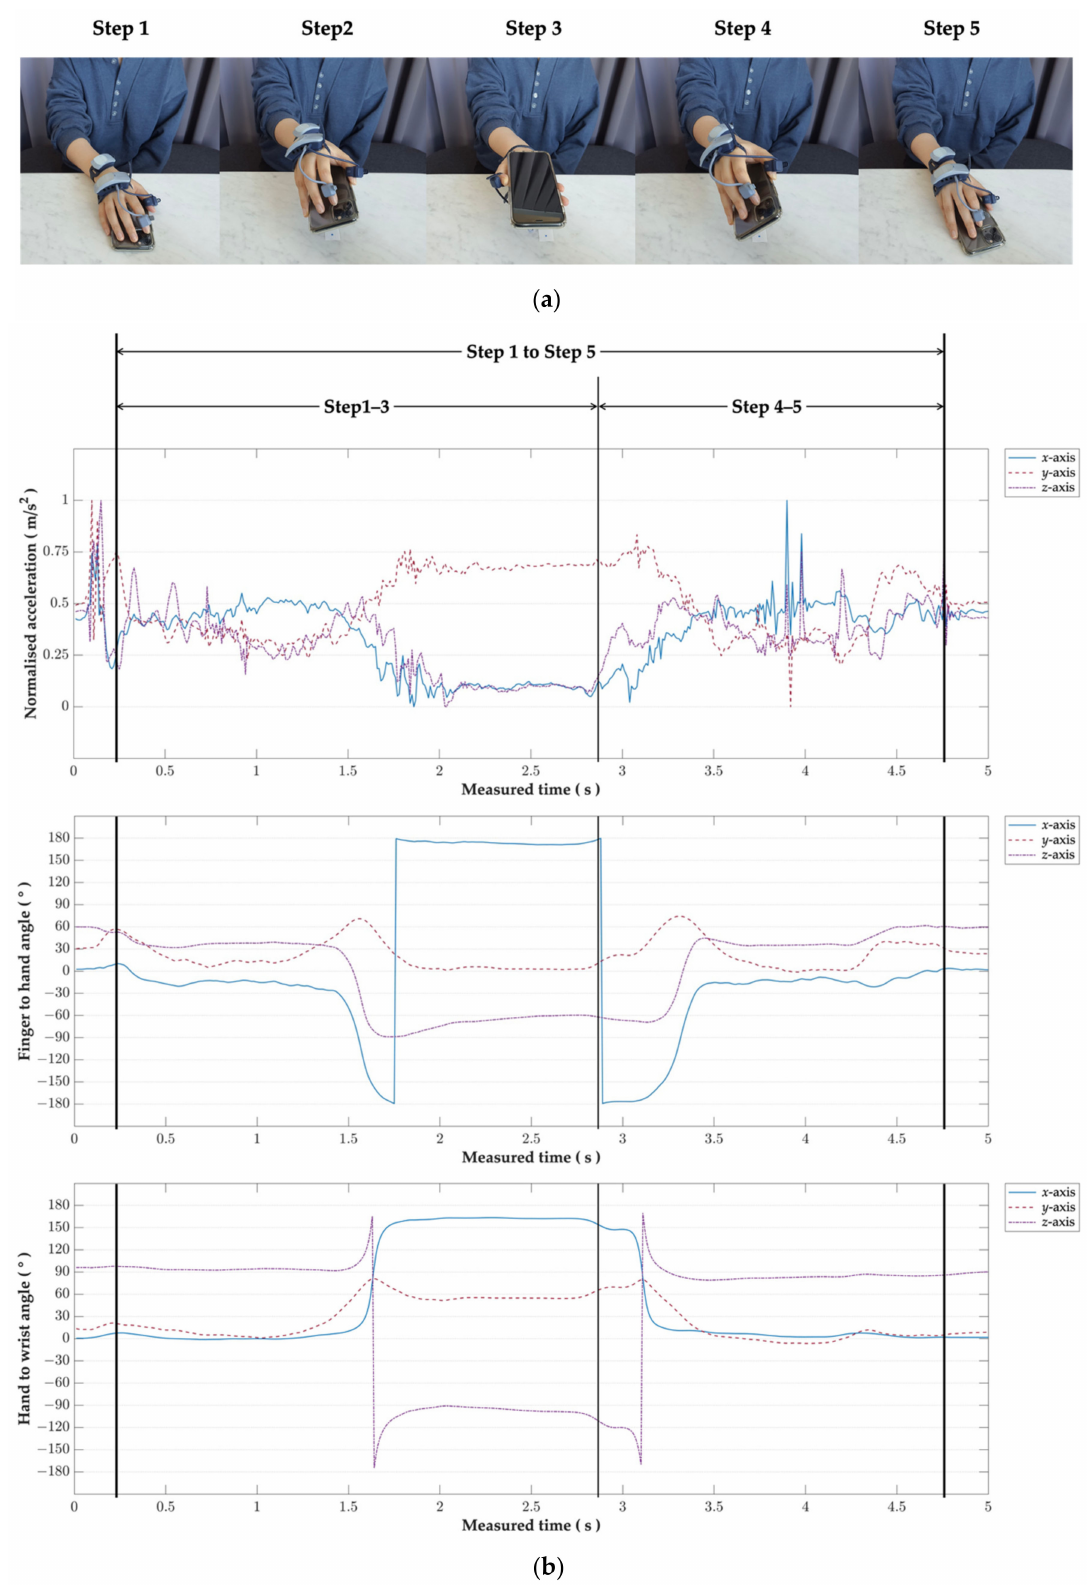
Figure 4. Hand movement sequences in Experiment 2: checking the time on a smartphone’s screen. ( a ) Motion sequence depiction into 5 steps; ( b ) IMU sensor output graph and intervals where the five-step motion sequence